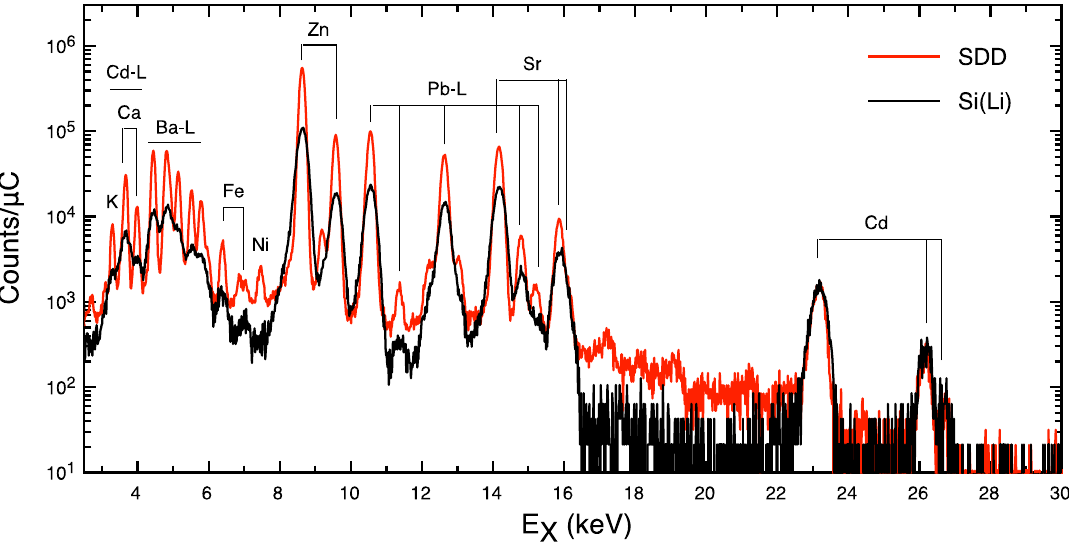
Figure 2. Comparison of PIXE spectra of a NIST 1412 glass obtained with 3 MeV protons, collected with a 150 mm 2 , 450 µ m thick SDD and with a traditional 80 mm 2 , 5 mm thick Si(Li) detector. The spectra are normalised by the proton beam charge accumulated during the measurements.